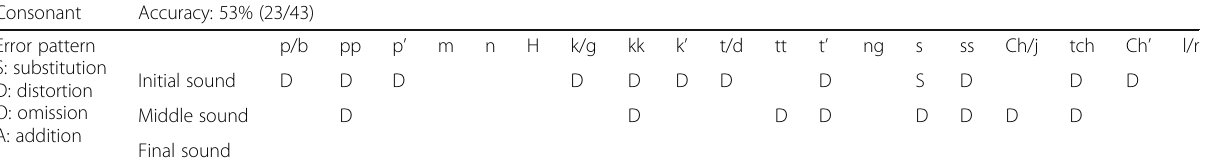
Table 1 Example table for consonant accuracy evaluation Consonant